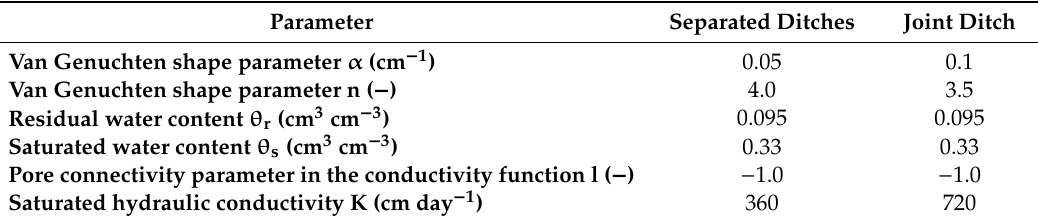
Table 6. Final data set for sandy tank material based on calibration using scenarios WW-Ref and WW-RE-Ref, the value for the pore connectivity parameter in the conductivity function, here − 1 was selected after